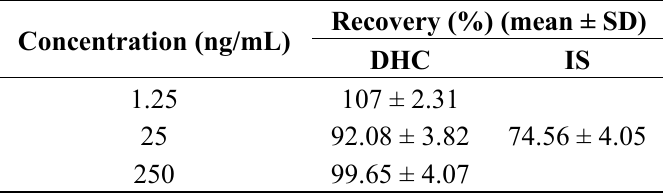
Table 2. The extraction recovery results for DHC in rat plasma (n = 6).